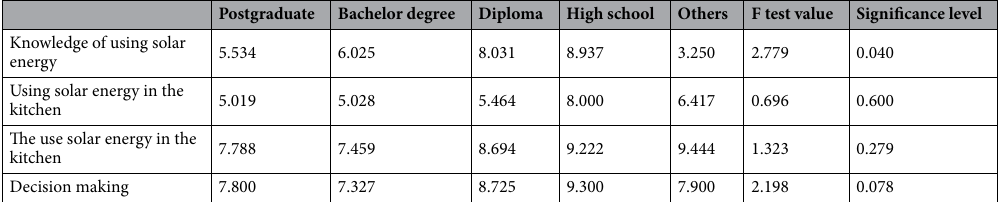
Table 6. Results significance level for educational level.